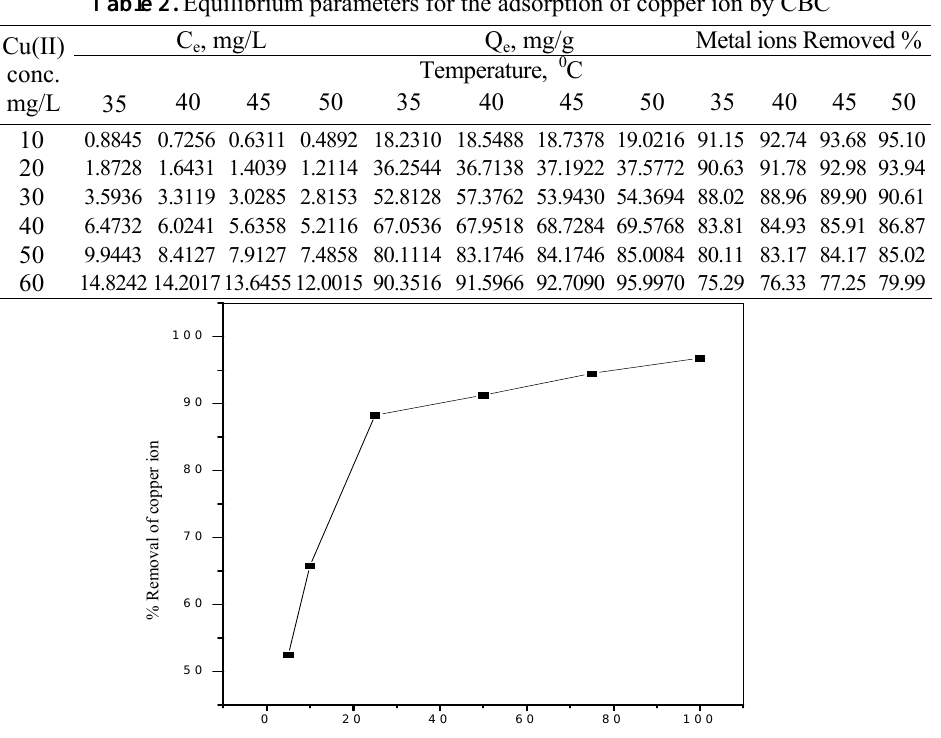
Figure 1 . Effect of adsorbent dose on the removal of copper ion by CBC [Cu]=30 mg/L; temp=35 o C; contact time = 60 min